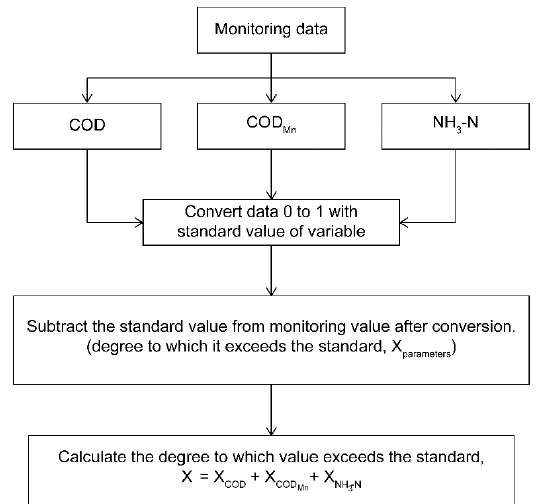
Water 2019 , 4 , x FOR PEER REVIEW Figure 8. Flow chart for calculating the pollution degree. Figure 8. Flow chart for calculating the pollution degree.